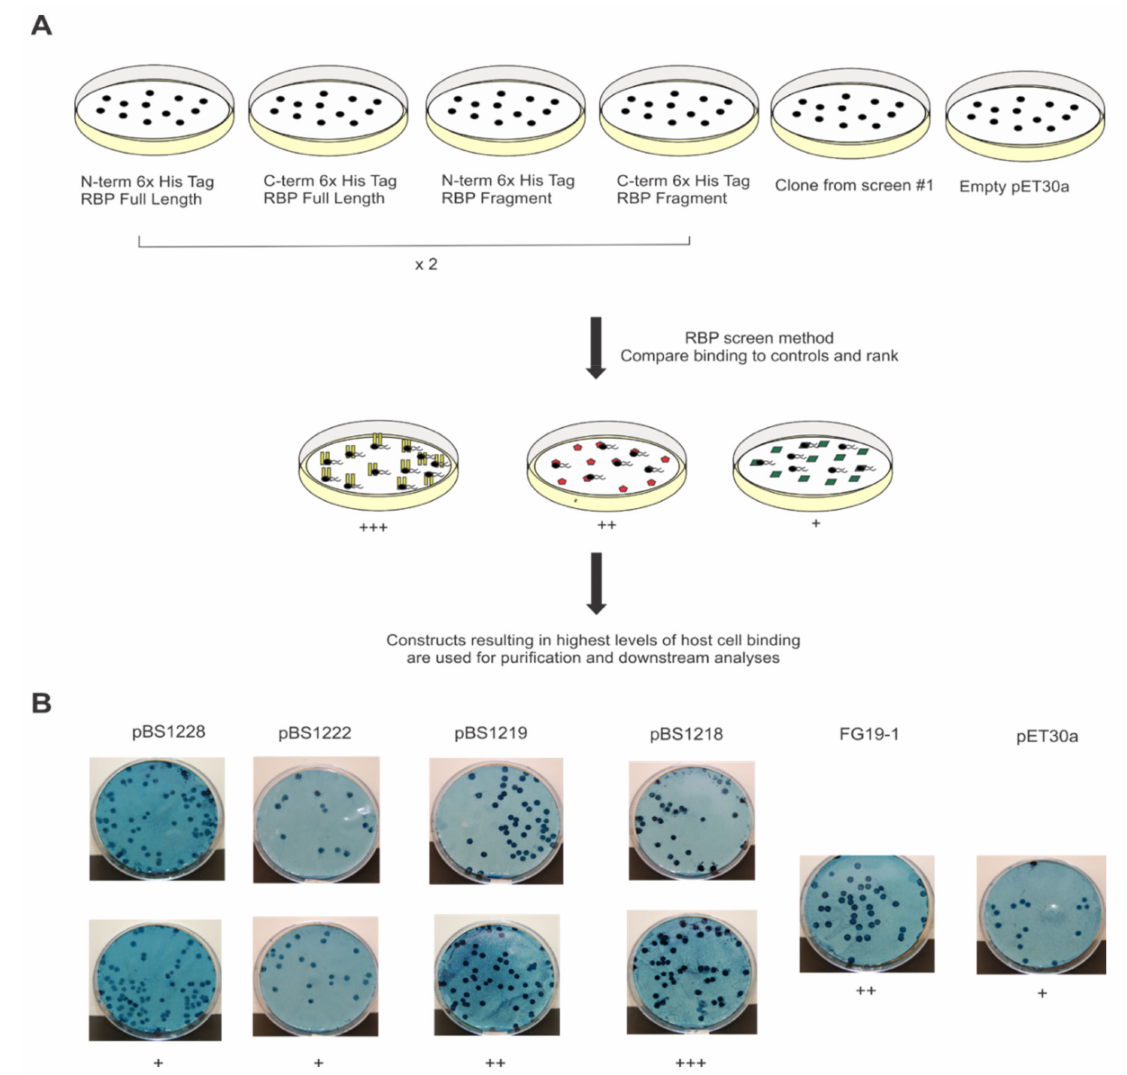
Figure 4. RBP confirmation screen summary. ( A ) transformants with known plasmid constructs were lifted onto nitrocellu- lose membranes and subjected to the RBP identification assay. Levels of host cell binding were phenotypically assessed compared to the controls (membranes containing empty pET30a or fragments identified in initial screen). ( B ) results following staining of membranes containing full length or truncated versions of Gp4 as well as positive and negative controls. Binding was graded as follows: (+++) specific binding in all or majority of areas containing protein, (++) binding in some areas containing protein, and (+) mostly nonspecific bacterial growth throughout the